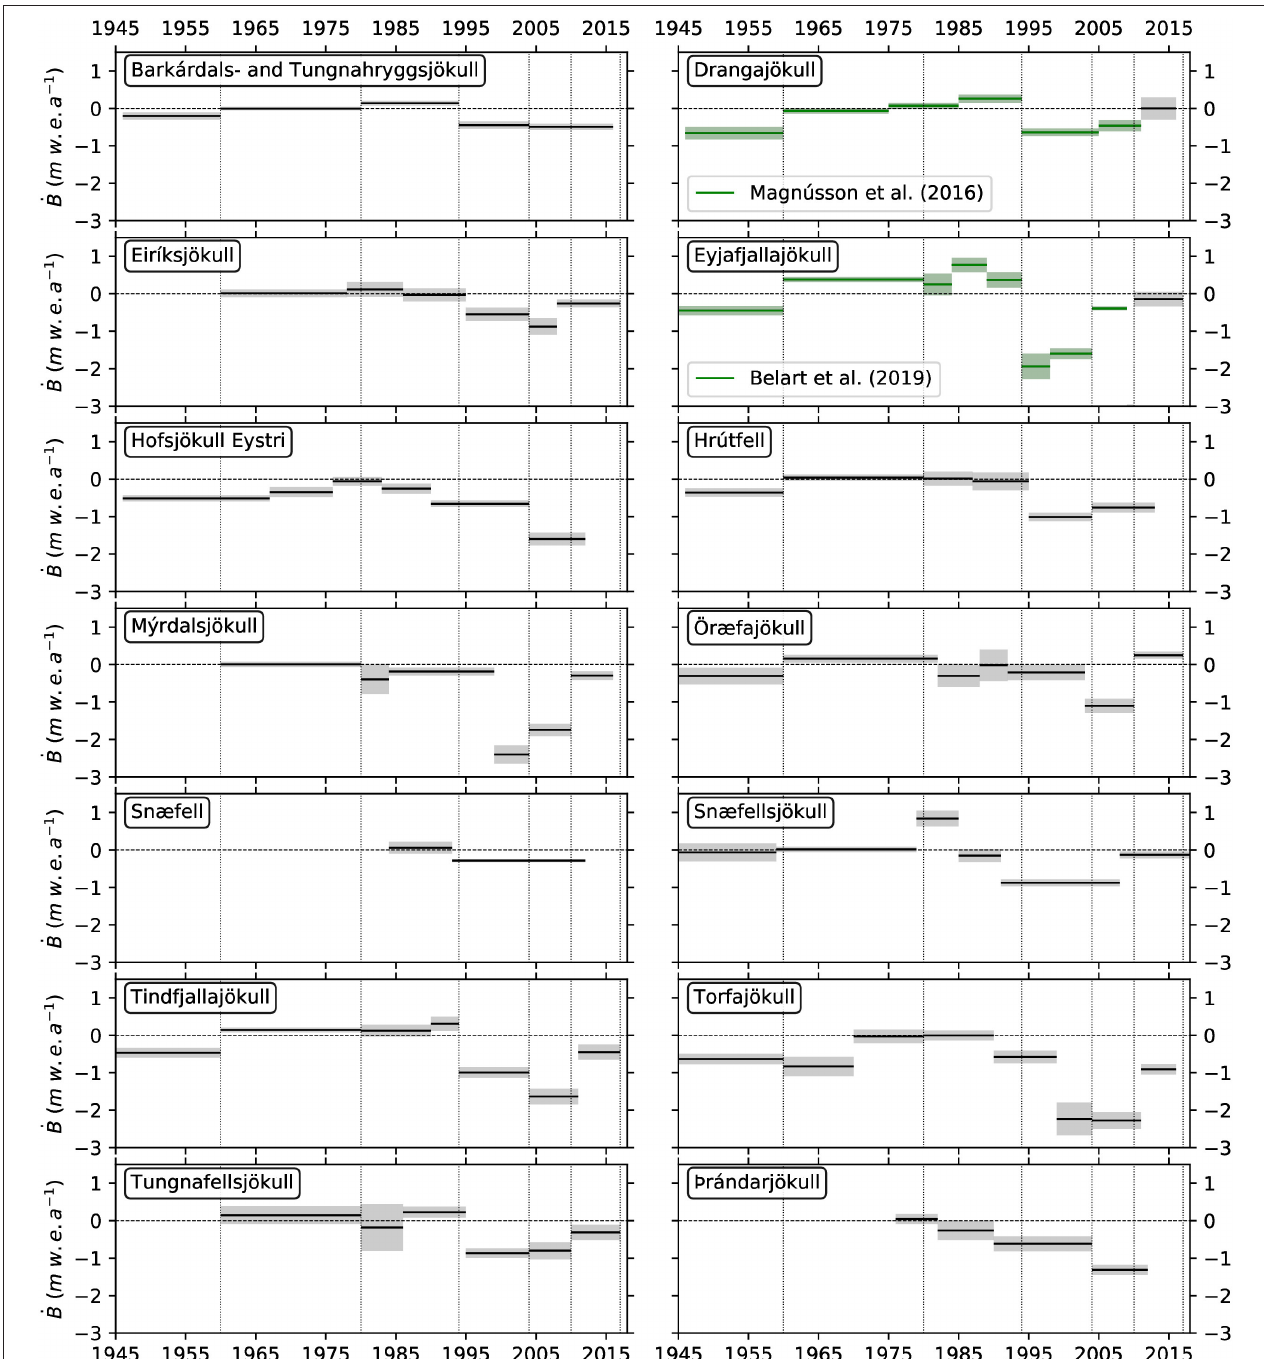
FIGURE 3 | Glacier-wide geodetic mass balance of the 14 glaciers. The mass balance is estimated from 1 October to 30 September (fixed-date system), based on seasonal corrections. Gray bands indicate uncertainty at 95% confidence level (Magnússon et al., 2016a). Dashed vertical lines show the years selected for a region-wide, temporally homogenized mass-balance comparison. Additional mass balances can be found in Table S1 , relative to longer time periods and for Torfajökull (1970–1979 and 1979–1990) and Tindfjallajökull (1960–1978 and 1978–1980), which are further analyzed in the